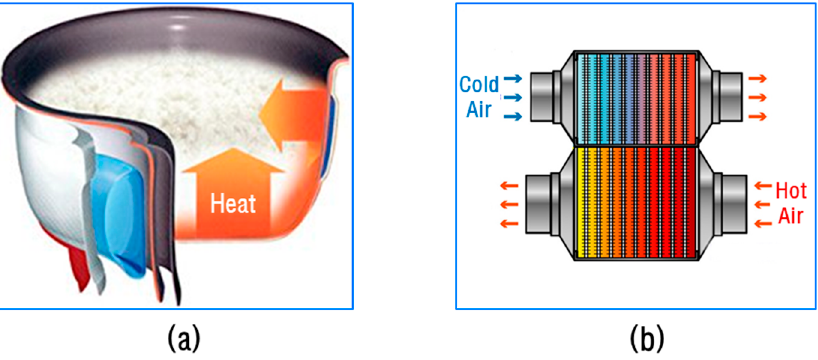
Figure 1. Clad metal application examples: ( a ) container in electric cookware, ( b ) heat exchanger.